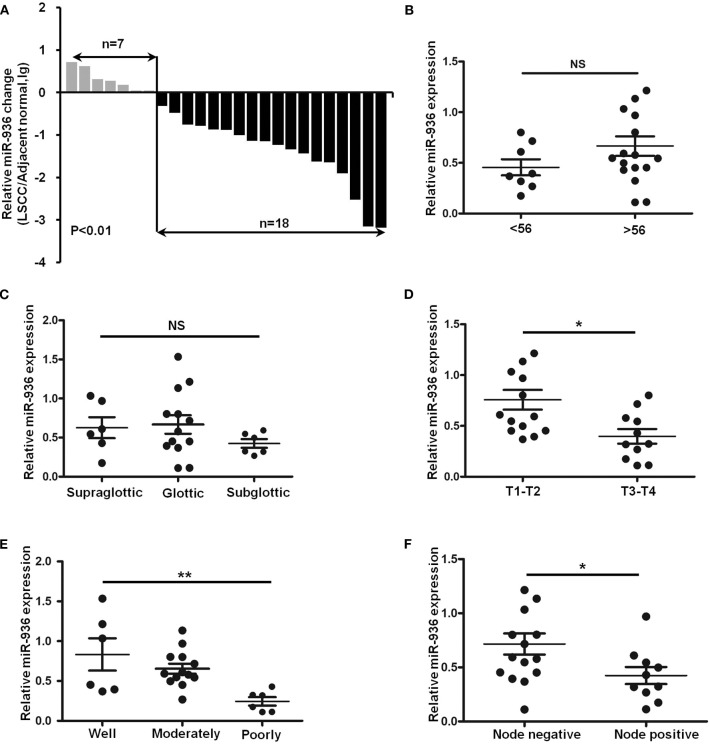
Downregulation of miR-936 in LSCC is correlated with T stages, differentiation and lymph node metastasis. (A) Expression of miR-936 in 25 pairs of LSCC tissues and adjacent normal tissues was detected using RT-qPCR. The relative miR-936 expression in two groups of LSCC tissues classified by age (B), T stage (D), and lymph node metastasis (F) were analyzed with Mann-Whitney U-test. The relative miR-936 expression in three groups of LSCC tissues classified by differentiation (C) and primary location (E) were analyzed with Kruskal-Wallis test. Data are presented as mean ± SD or median with the interquartile range. *p < 0.05; **p < 0.01; NS, no statistical significance.